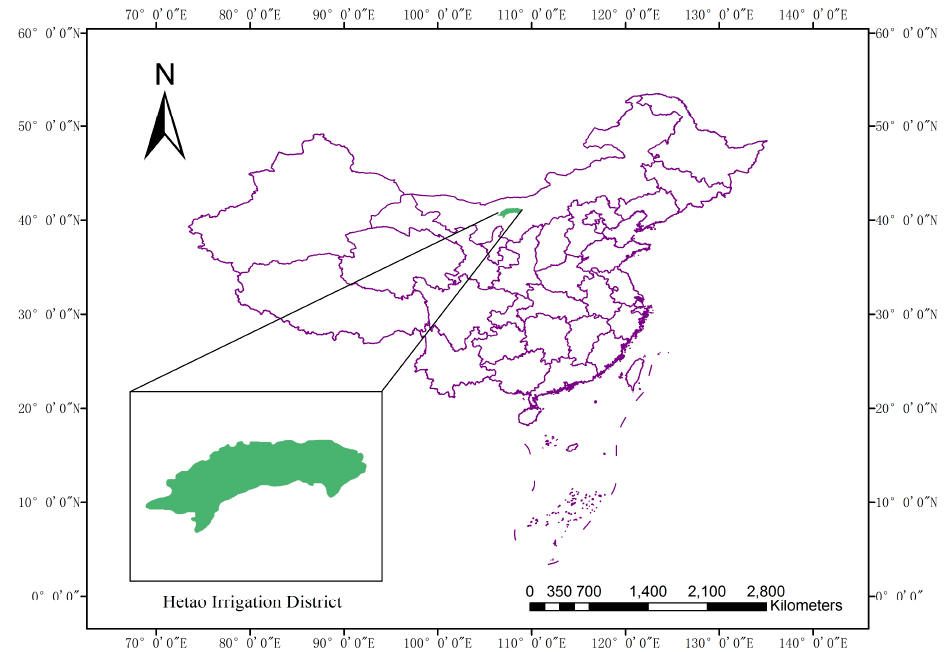
Figure 1. The location of the Hetao Irrigation District.